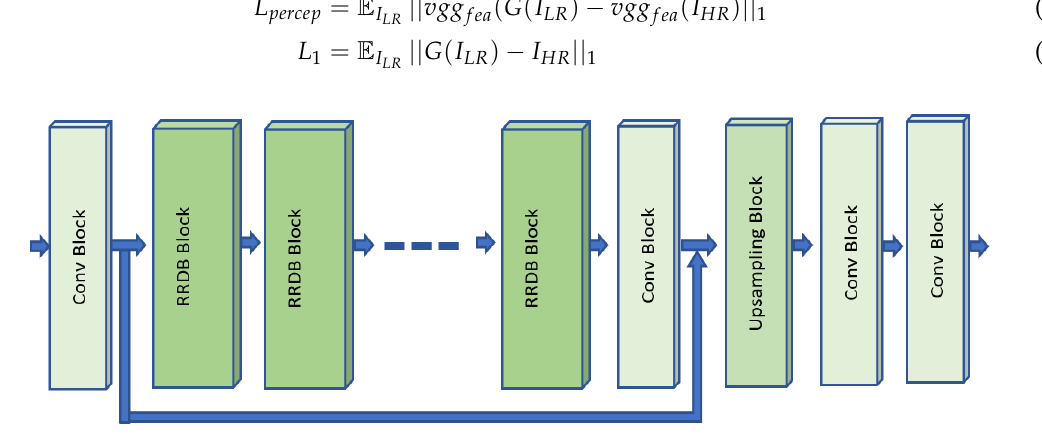
Figure 3. Generator G with RRDB (residual-in-residual dense blocks), convolutional and upsampling blocks.